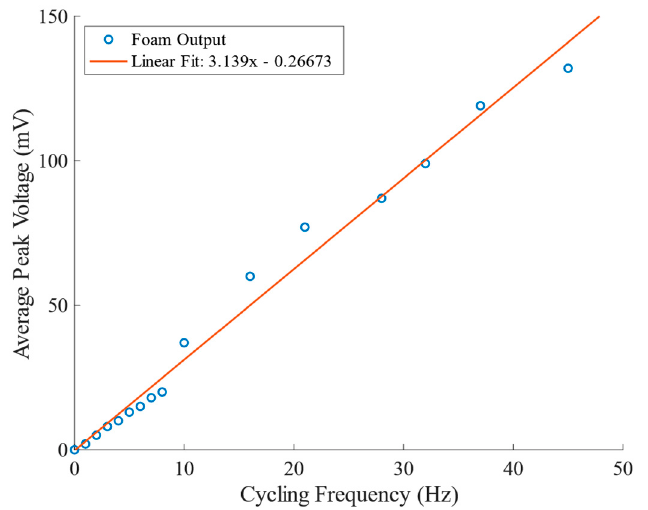
Figure 6. Average peak voltage response versus cycling frequency, 1–45 Hz.